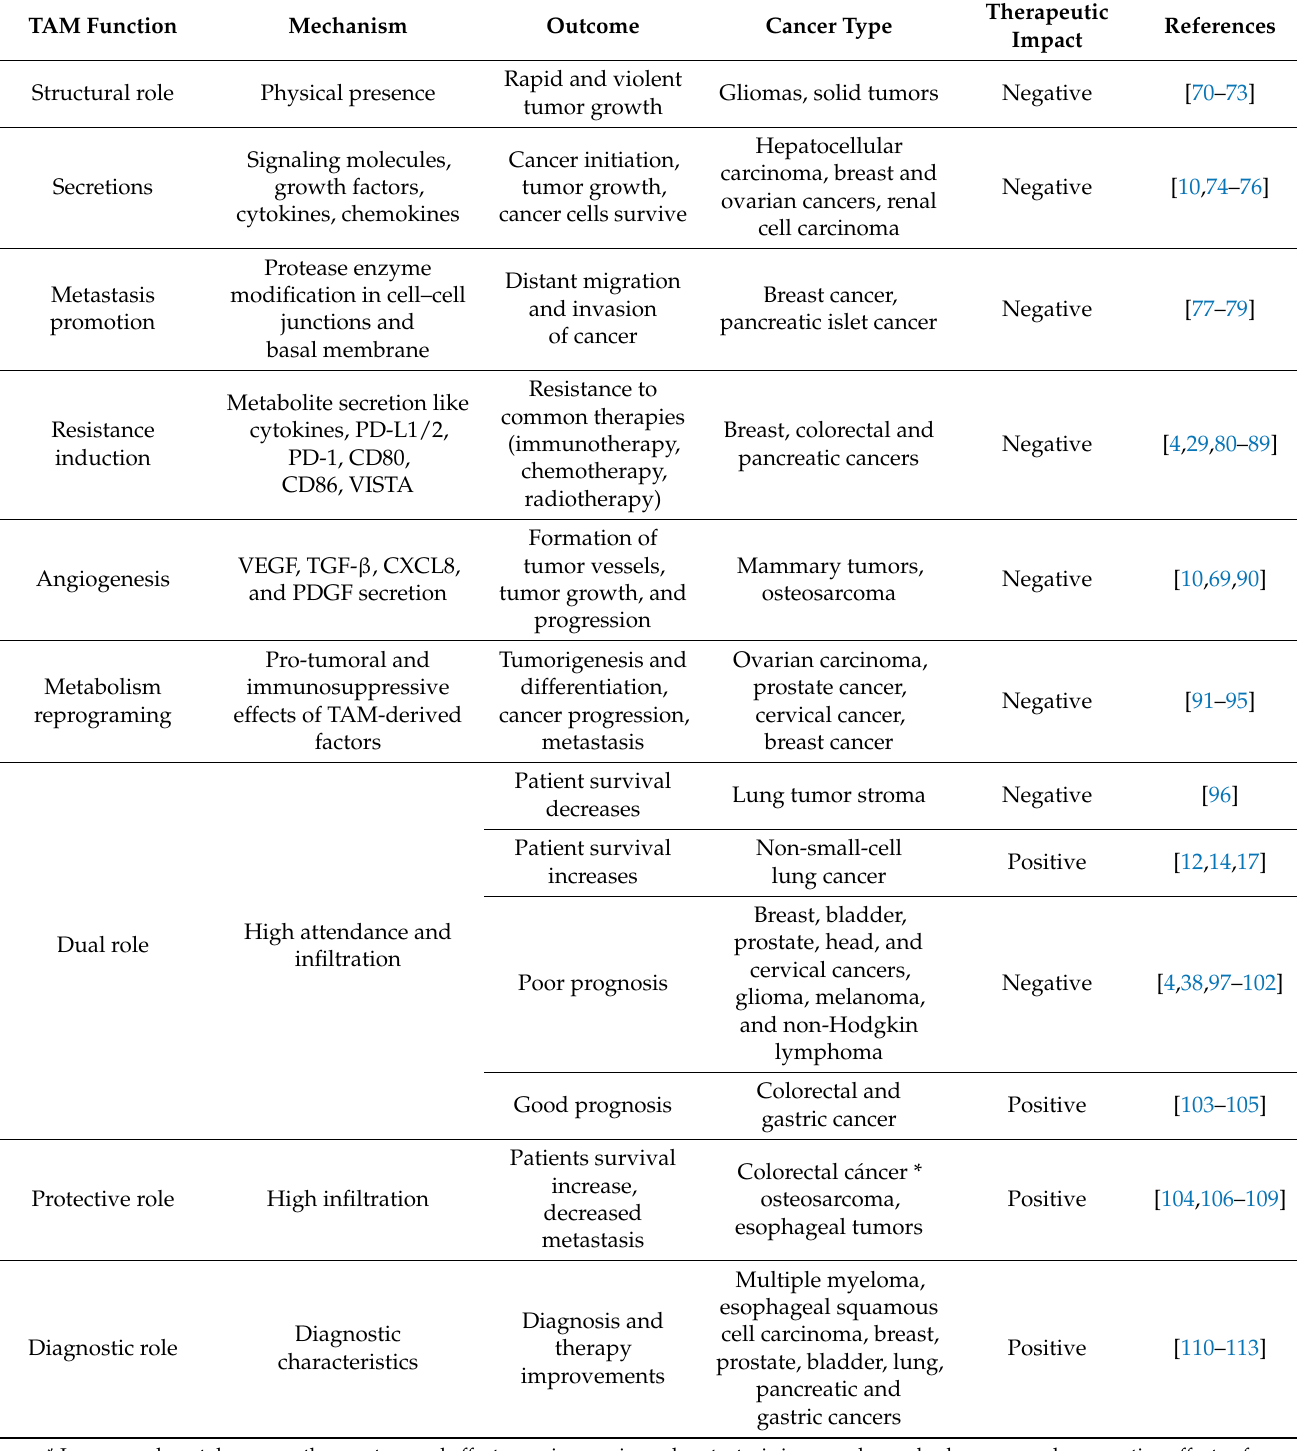
Table 1. Adversarial and beneficial effects of the TAM functions in several cancer